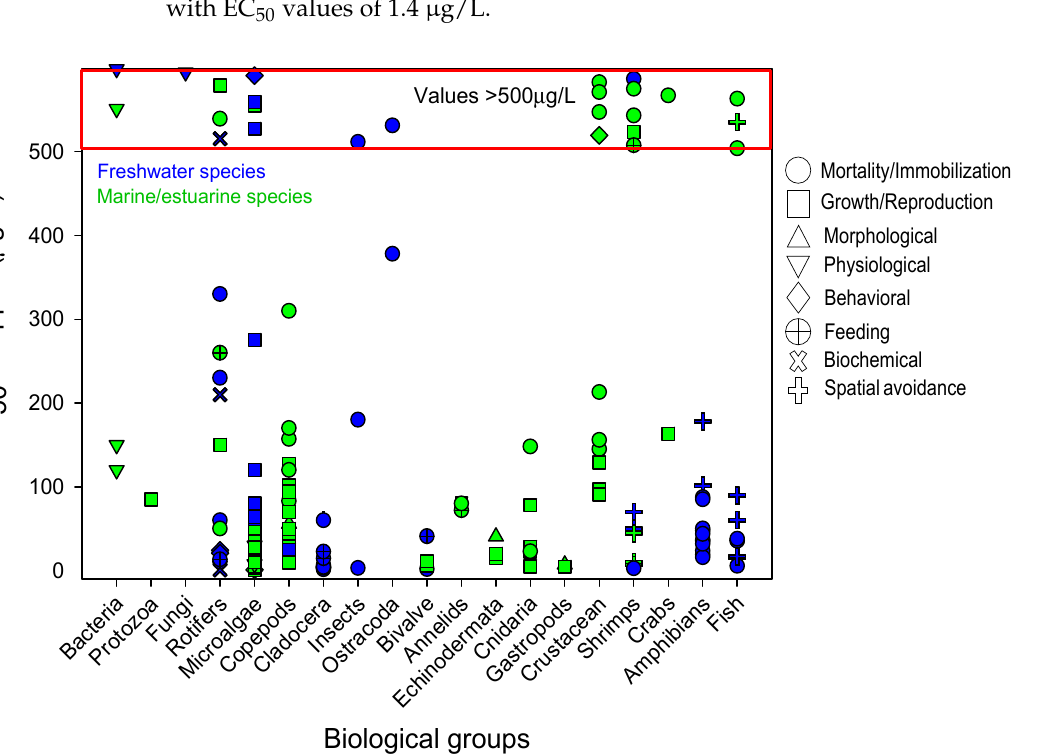
Figure 1. Sensitivity profile for the biological groups exposed to copper-based on the EC 50 values. The effects, represented by different symbols, were classified according to Table 1. Data in blue and green represent, respectively, freshwater and estuarine/marine species. Data shown in the red zone represent results whose EC 50 values are higher than 500 µg/L; therefore, the scale should not be considered in this zone (see real data in Table S1).